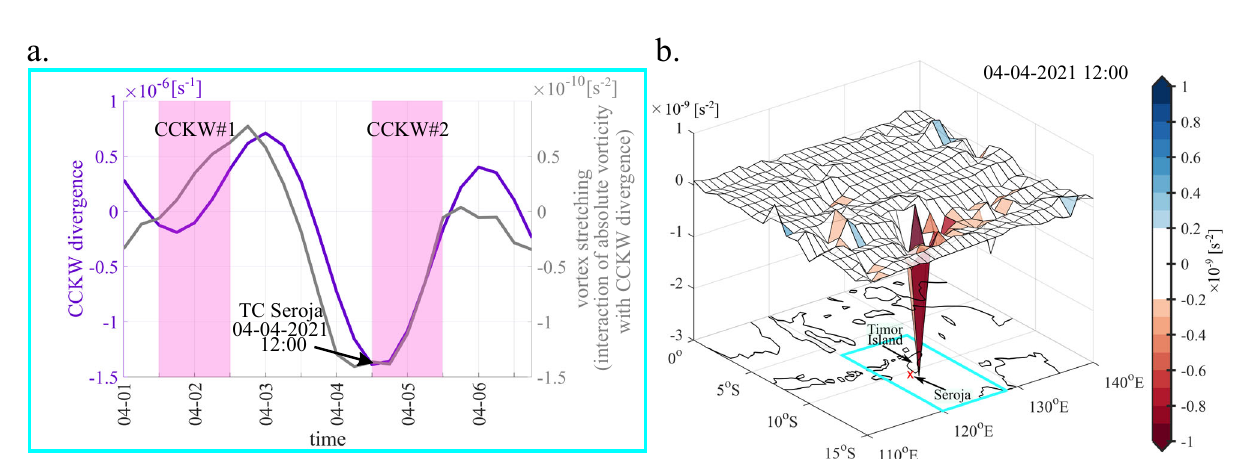
b Vortex stretching (colour-shaded): low-level CCKW divergence acting on abso- lute vorticity at 12 UTC April 4, 2021. Red sign on the underlying map shows the location of Tropical Cyclone Seroja vortex. The box which is analysed on a is marked in b